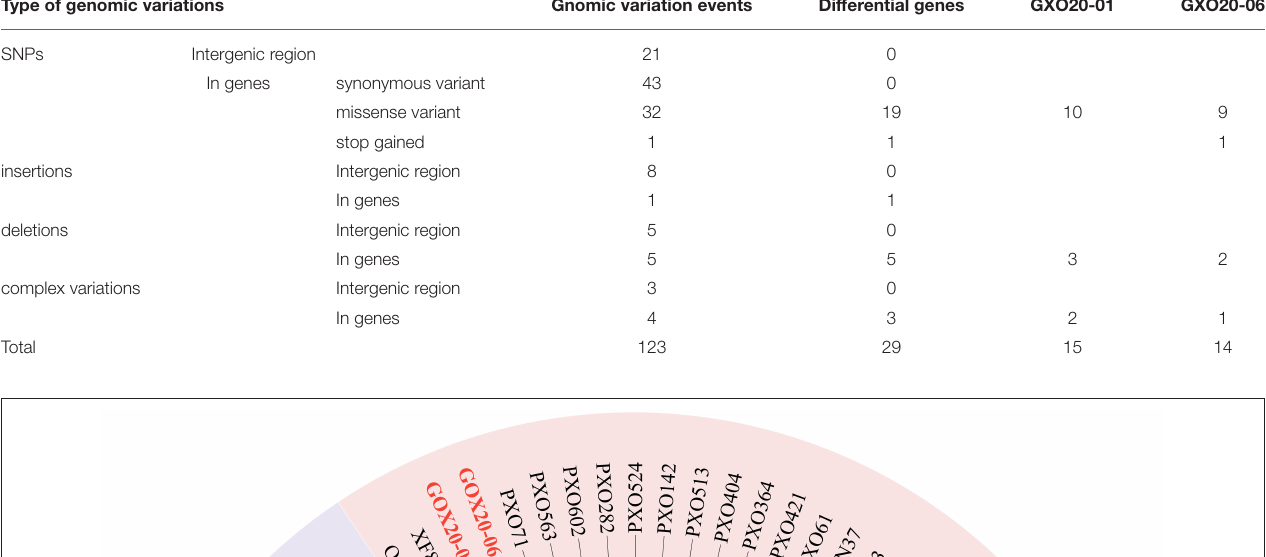
TABLE 3 | The genomic variations and differential genes between Xoo strains GXO20-01 and GXO20-06.